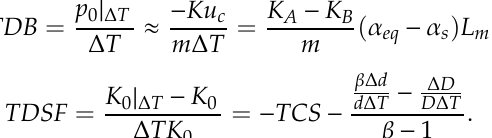
Figure 6. The change trend with the total thickness of silicon which is at the bottom of the SOI for the α of the four theoretical calculation methods and two numerical simulation methods.